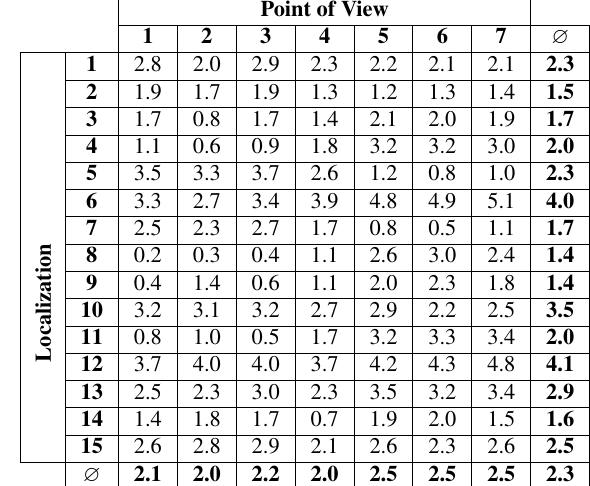
Table 1. Overlay error [cm] between the real and the virtual evaluation marker depicted in Figure 5 for all localizations and points of view (see Figure 8 for positions of the points of